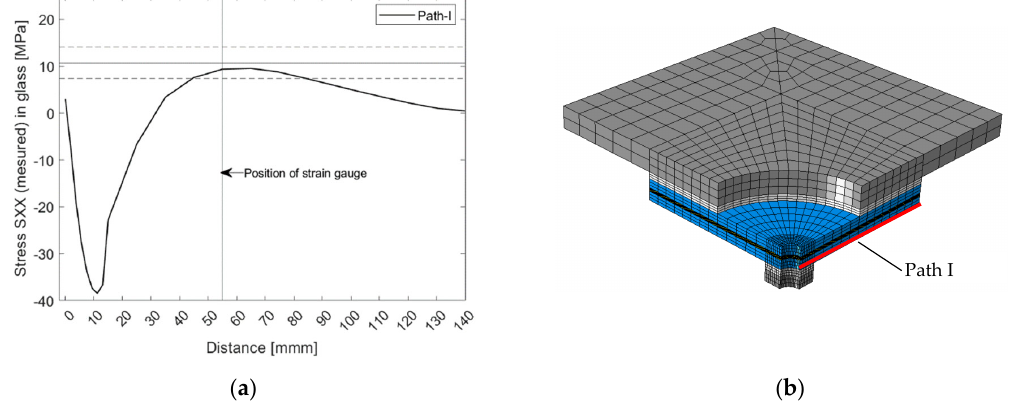
Figure 12. Results of the numerical study for test series G8: ( a ) stress SXX profile along Path ‐ I; ( b ) location of Path ‐ I.